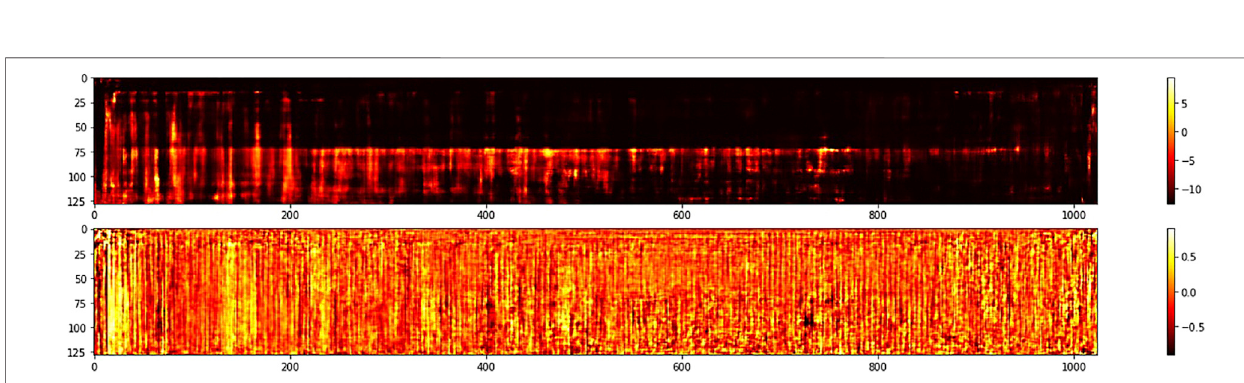
FIGURE 5 | MFCC of a new chord generated by the network ’ s decoder by sampling an untrained point in the latent space. The horizontal dimension represents time while the vertical dimension encodes frequency coef fi cients. Brighter yellow colors represent higher sound intensities. The top graph shows the magnitude of the frequency representation and the bottom displays its